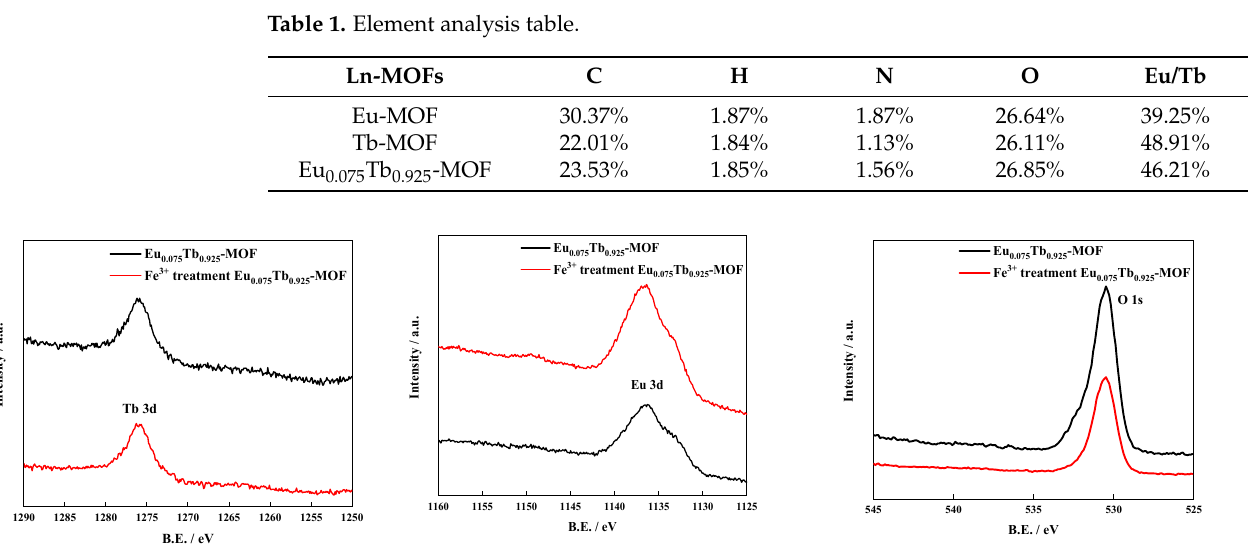
3+ addition: ( a ) Tb 3d, ( b ) Eu 3d, and ( c ) O